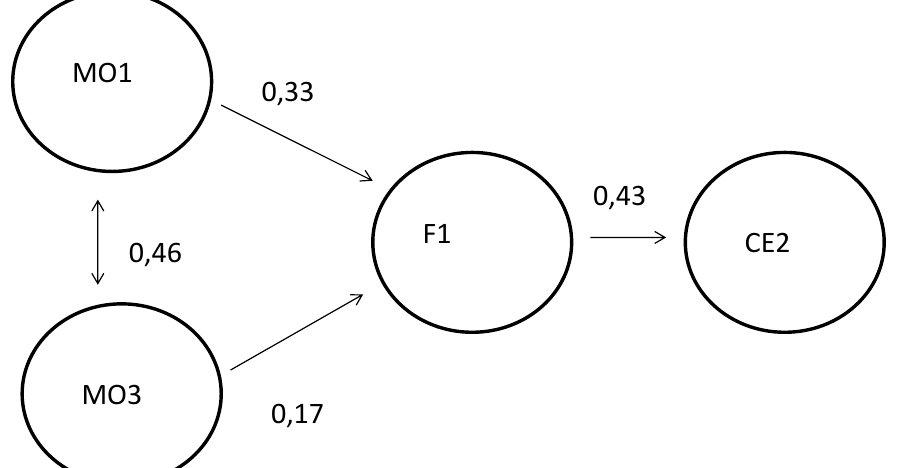
Figure 2: Structural Equations Model with the corporate entrepreneurship sub-scale of work discretion as outcome variable.